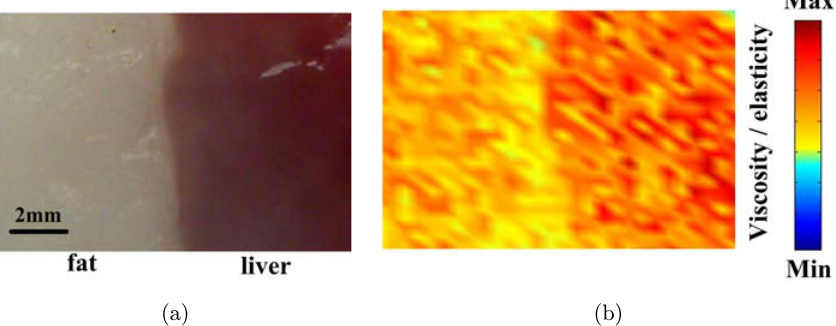
Fig. 5. (a) Photograph of biological tissues (fat and liver). (b) Viscoelasticity distribution of the sample detected by